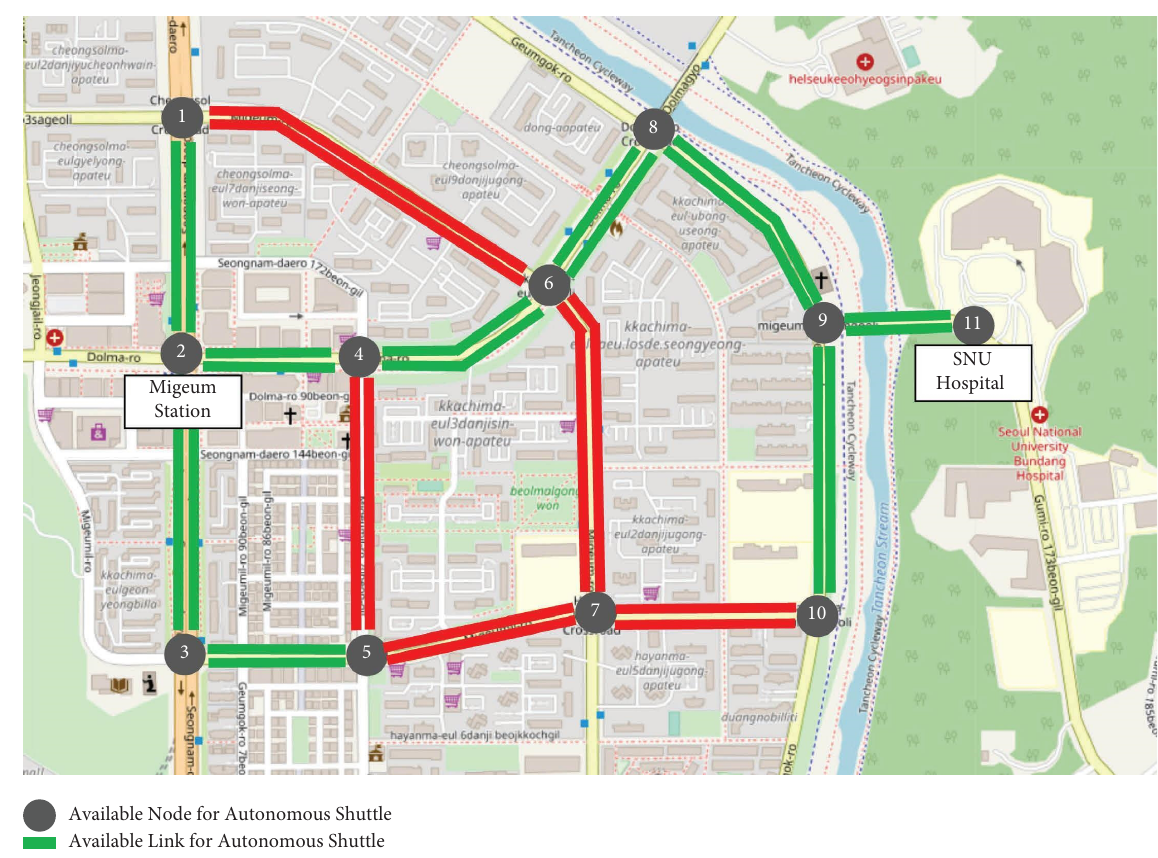
Figure 19: Result of autonomous shuttle operation feasibility analysis based on ODD for < hospital > major route.